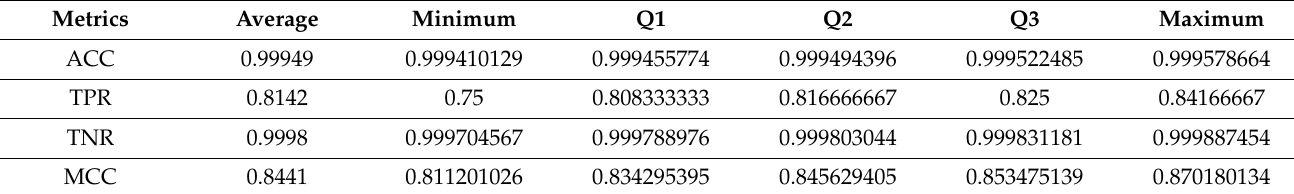
Table 1. Performance of AE-PRF in 50 times of experiments ( θ =